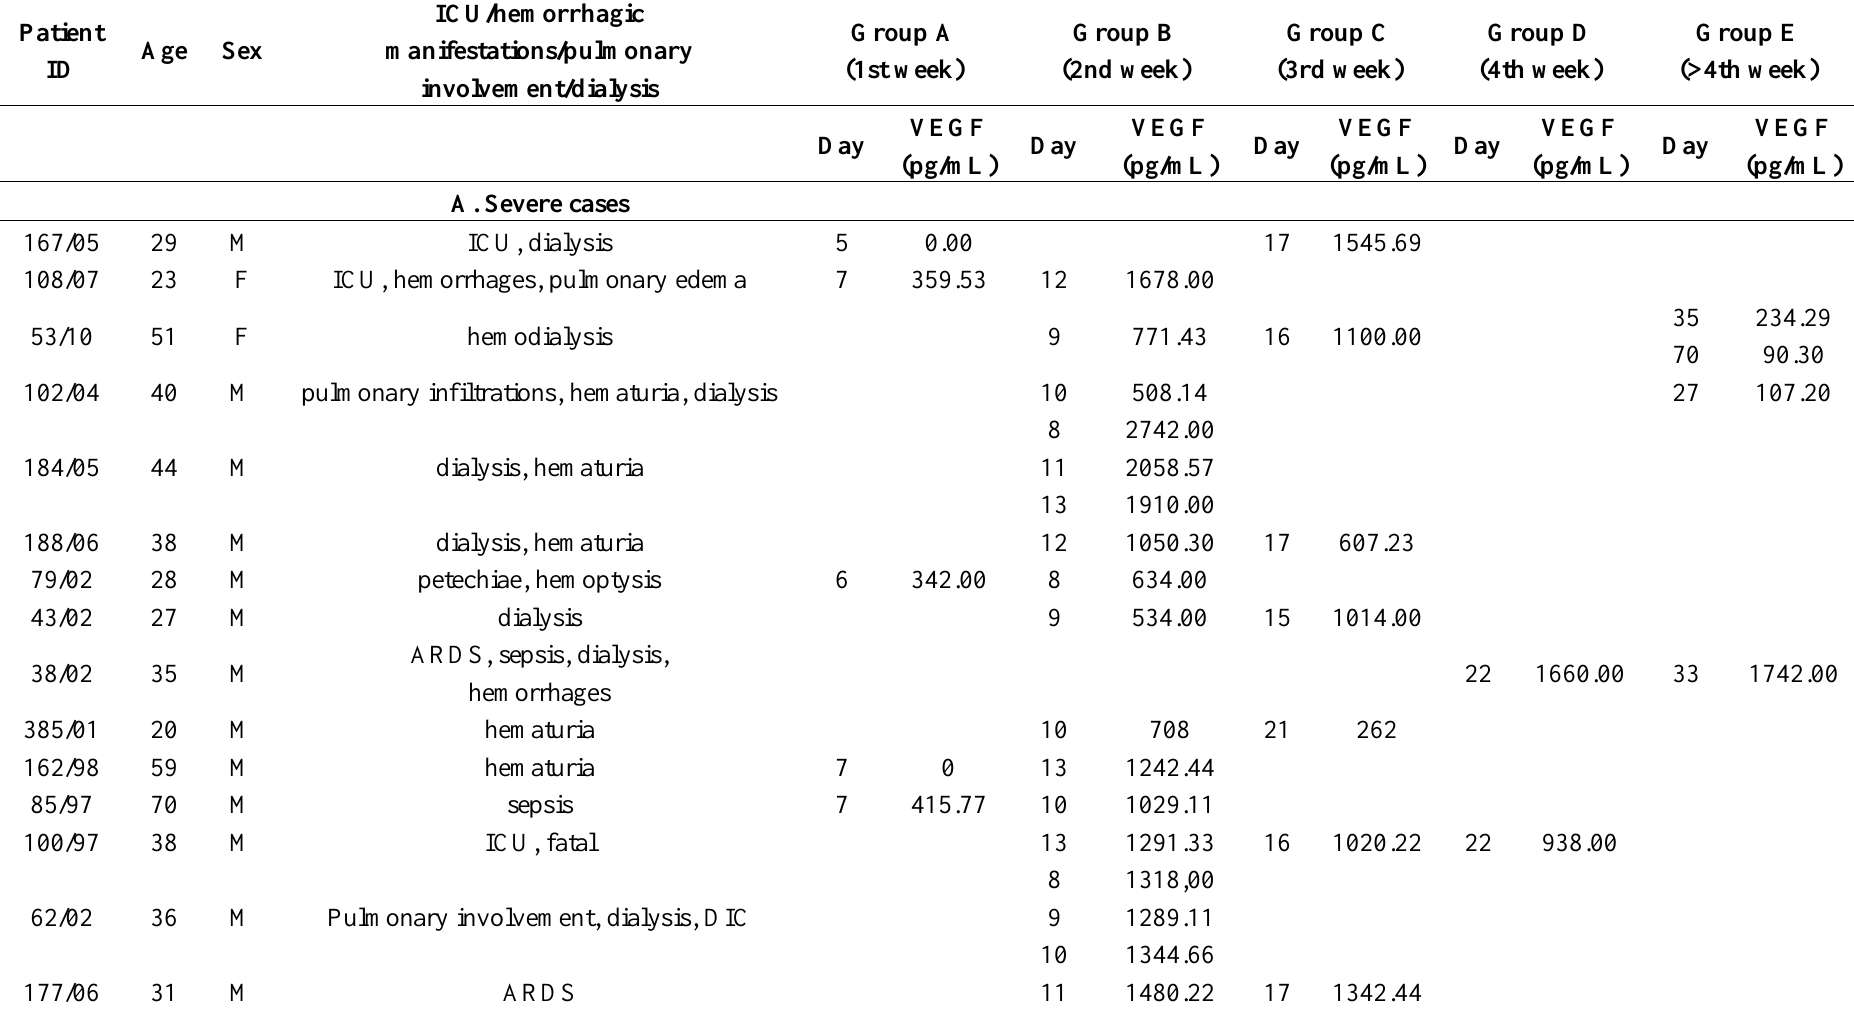
Table 2. Serum VEGF levels in 32 patients with DOBV infection for whom serial samples were available. A. severe cases, B. non-severe cases. The day of illness, and data about hospitalization in intensive care unit (ICU), need of dialysis, presence of hemorrhagic manifestations, and pulmonary involvement are shown. ARDS: acute respiratory distress syndrome. DIC: Disseminated intravascular